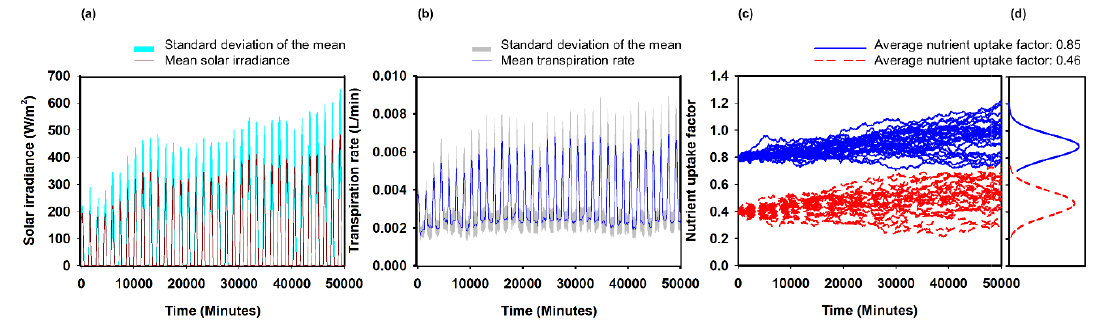
Figure 3. Random walk cloud cover and vapor pressure deficit (VPD) applied solar irradiance ( a ) and transpiration model ( b ), and stochastic changes in nutrient uptake factor ( c ) and its normal distribution ( d